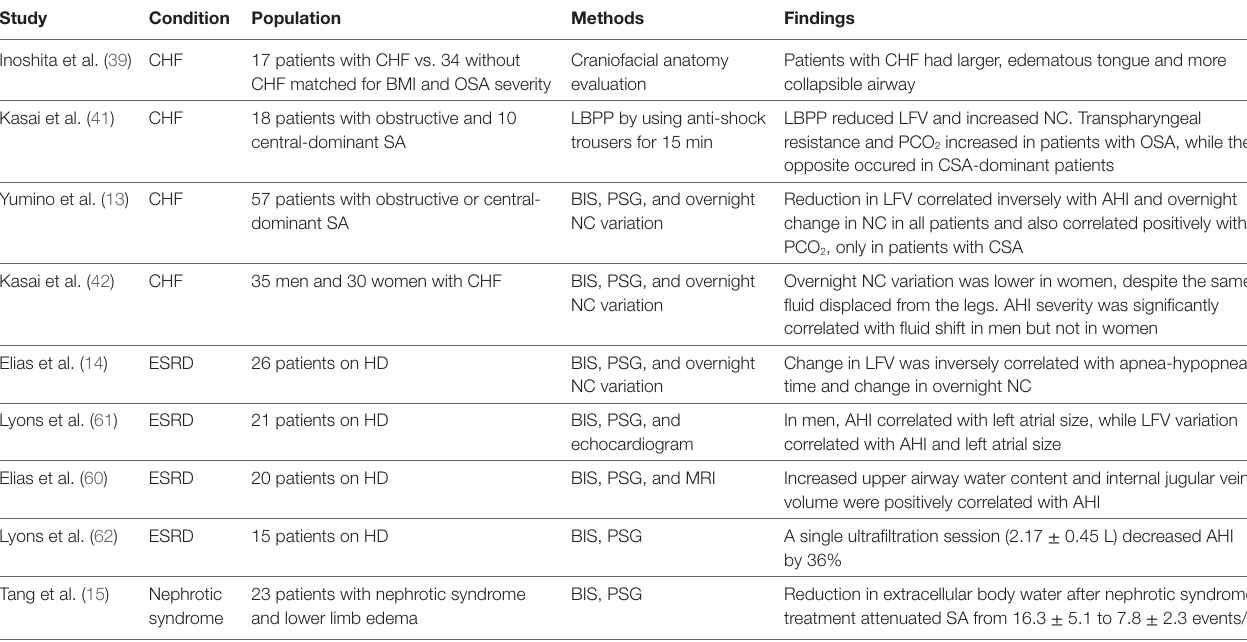
TAble 1 | Studies on the relationship between volume overload and SA that have included patients with fluid-retaining states. Study Condition Population Methods